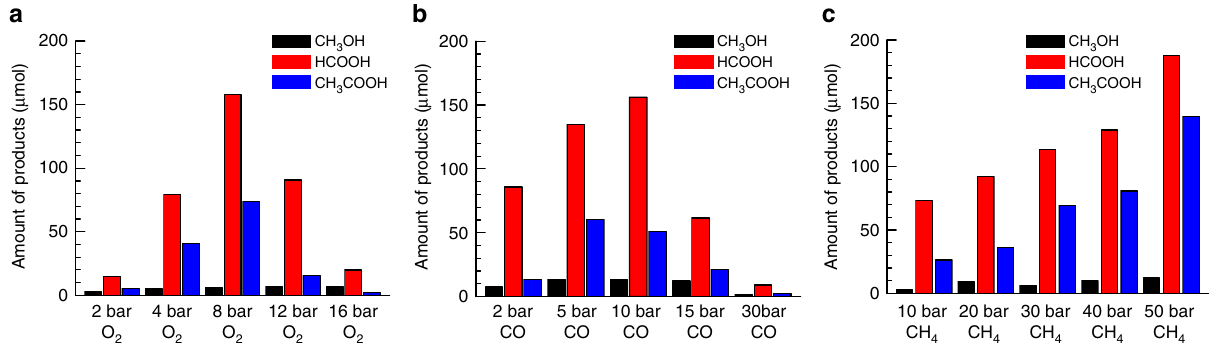
Fig. 3 In fl uence of partial pressure O 2 , CO and CH 4 on catalytic performances. Yields of methanol (black), formic acid (blue), and acetic acid (red) in the chemical transformation of CH 4 at 150 °C in aqueous solutions at different pressure of O 2 , CO, CH 4 . a 35 bar CH 4 , 10 bar CO, and different pressure of O 2 at 150 °C for 2 h. b 50 bar CH 4 , 8 bar O 2 , and different pressure of CO at 150 °C for 1.5 h. c 10 bar CO, 8 bar O 2 and different pressure of CH 4 at 150 °C